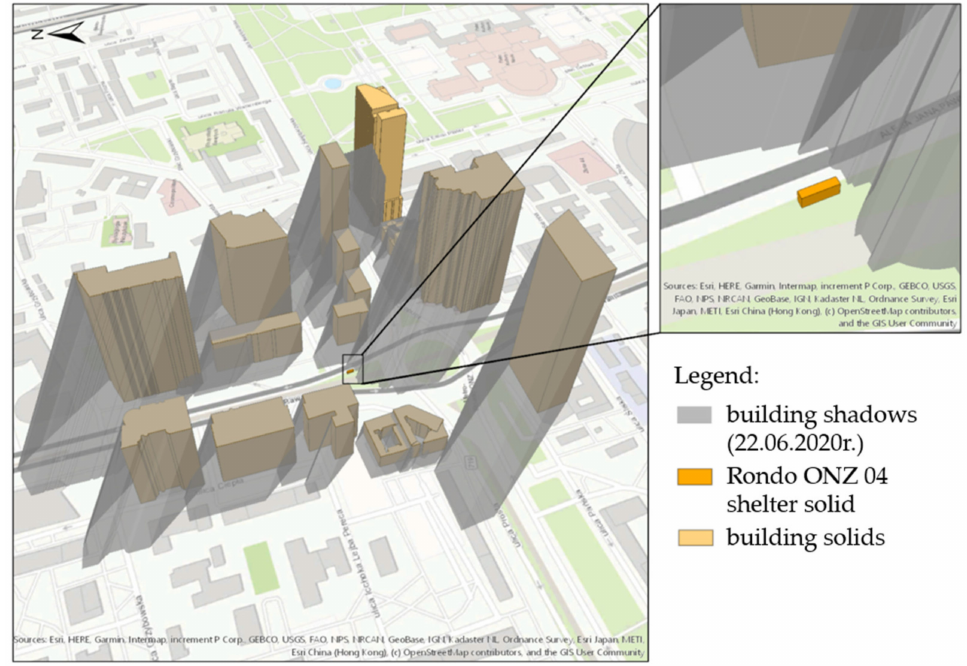
Figure 19. Arrangement of buildings and their shadows for the neighbourhood of Rondo ONZ 04 tram stop generated for 22 June 2020 at 10:30 a.m.